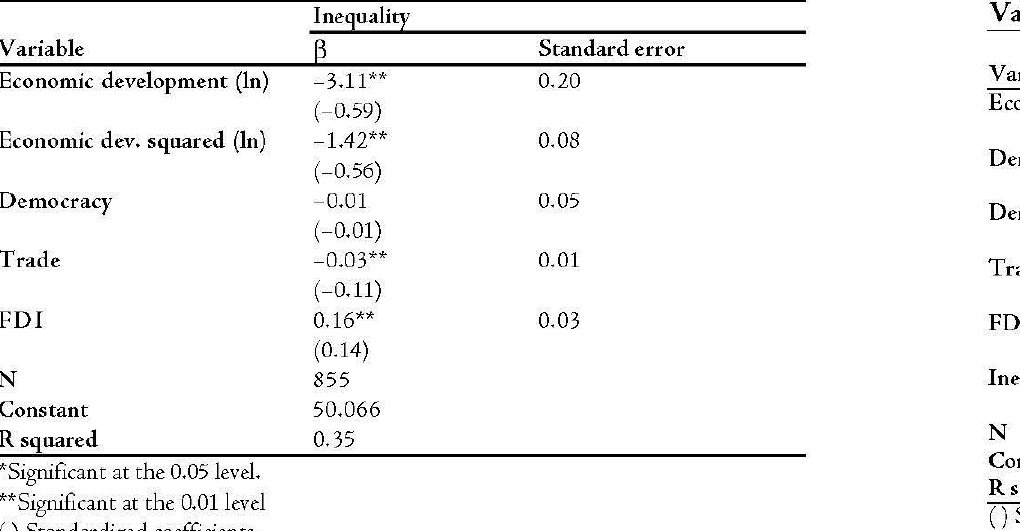
OLS Regression for Inequality, 1980-93 Cross-Sectional OLS Regression for Political Instability, Average